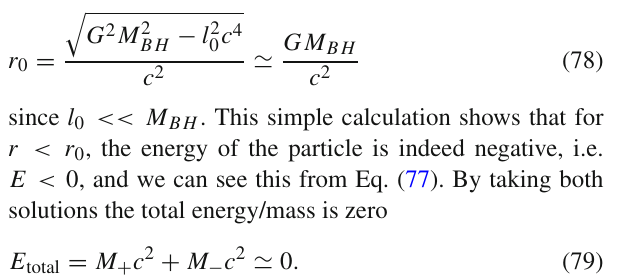
For simplicity, we take the kinetic energy to be zero,